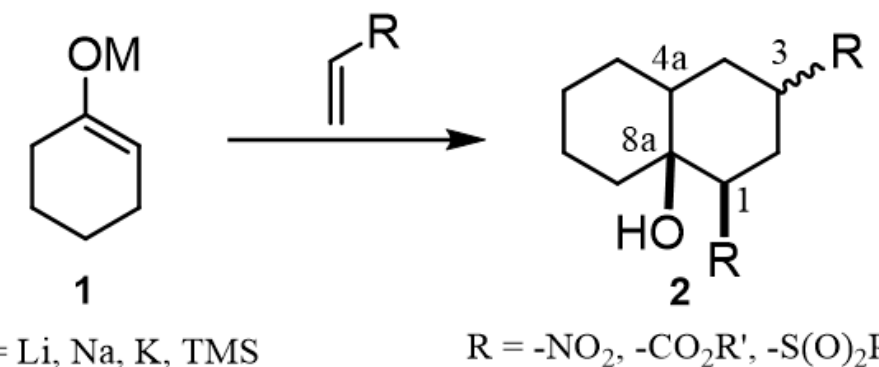
Figure 1. General approach for the synthesis of decalin derivatives via Michael’s double addition of cycloalkanone enolates over conjugated vinylic systems.